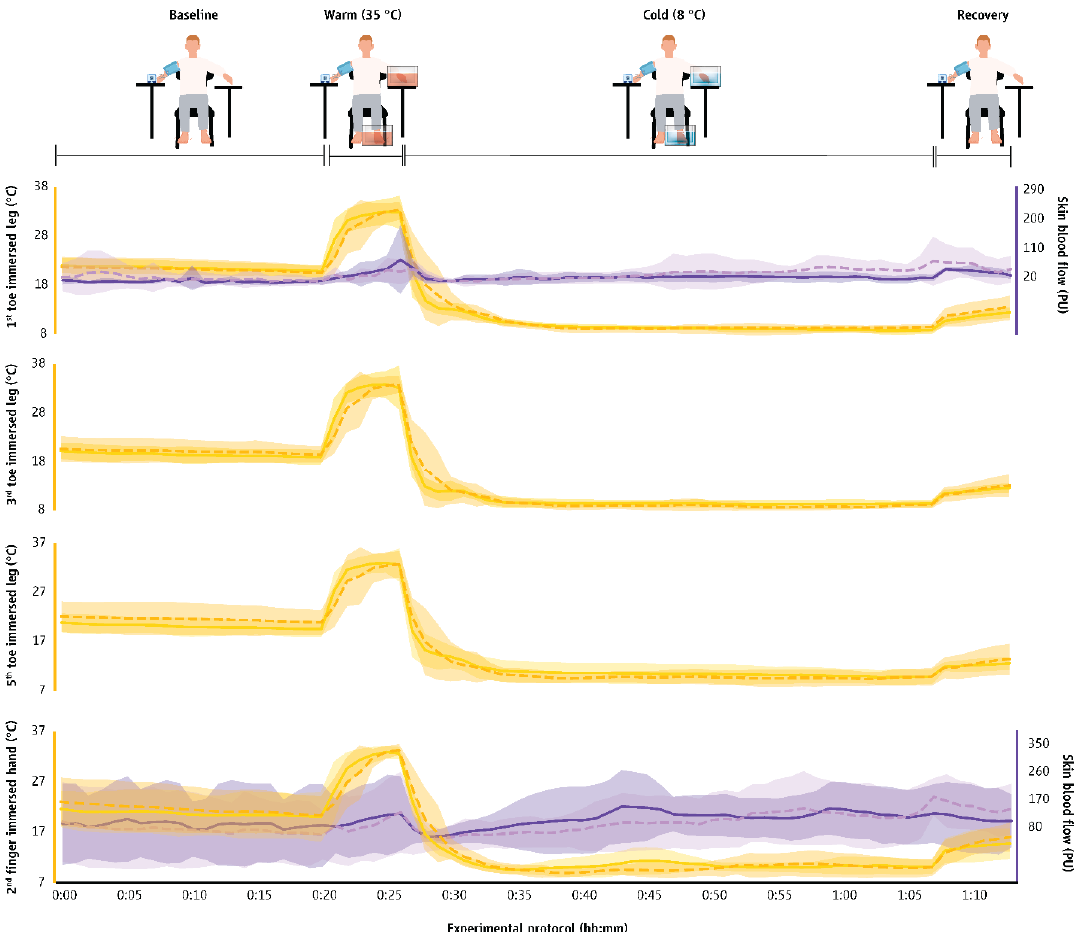
Figure 4. Skin temperature and blood flow (mean ± SD) in the fingers and toes during exposure to the cool environment (16 ± 1 °C) in the two groups. The first 20 min (00:00 to 00:20) indicate data collected during the baseline phase, the next five min (00:20 to 00:25) indicate responses during the warm-water immersion, the next 40 min (00:30 to 00:70) indicate responses during the cold-water immersion, and the final five min (00:70 to 00:75) show responses during the recovery phase. Finger and toe temperatures are indicated with continuous yellow lines in men and with dashed yellow lines in women. Finger and toe skin blood flow data are indicated with continuous purple lines in men and with dashed purple lines in women.